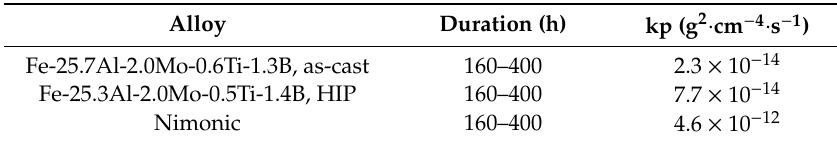
Table 2. Parabolic rate constants k p measured in synthetic air at 900 ◦ C. The duration specifies the time range used to determine k p .